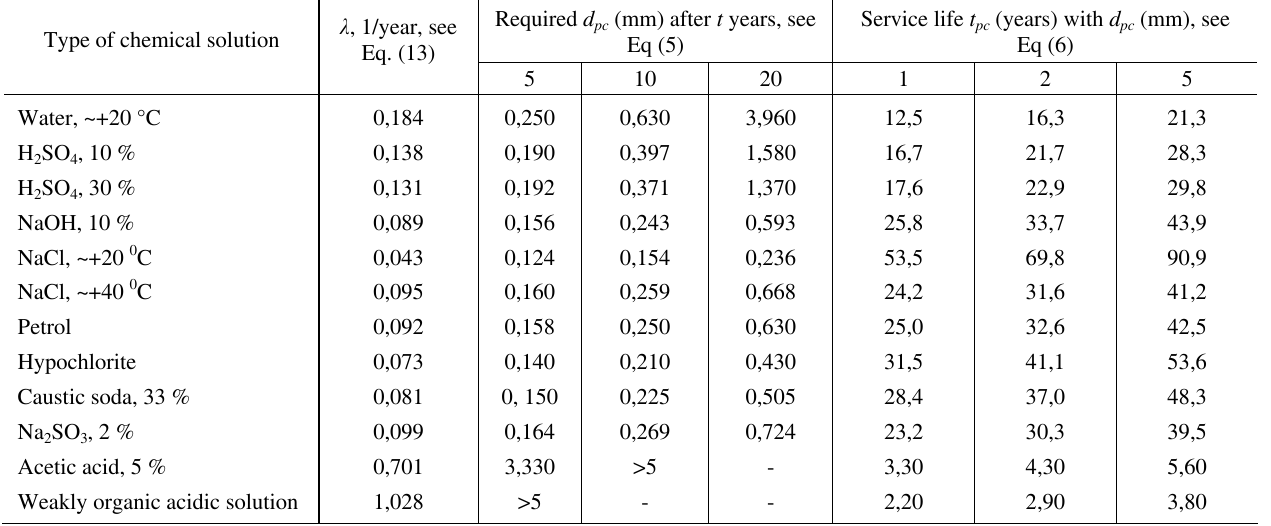
Table 2. Coatings durability computed according to Eqs (5), (6) and (13) Required d pc (mm) after t years,